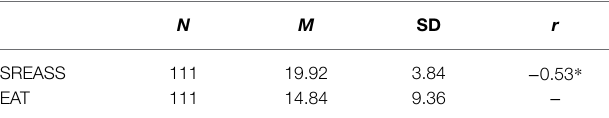
TABLE 1 | Descriptive statistics and post-hoc